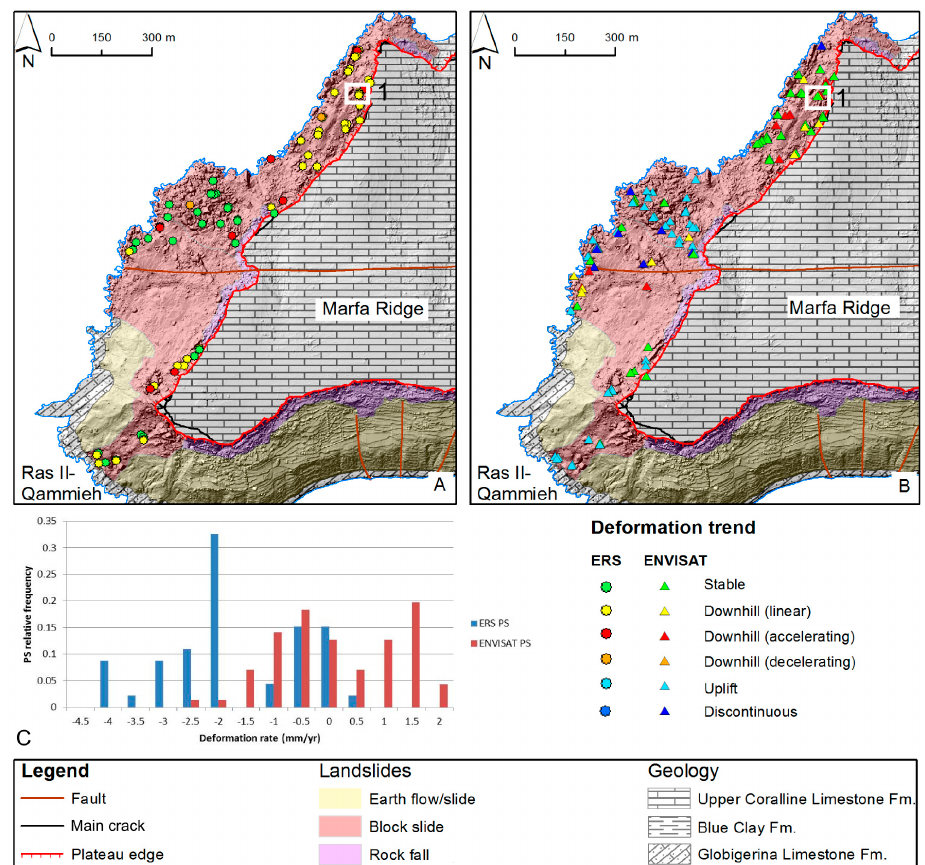
Figure 8. Marfa Ridge landslide map and distribution of the PS, color coded according to the trend classes defined in Figure 4: ( A ) ERS satellite PS deformation trend; ( B ) ENVISAT satellite PS deformation trend; ( C ) Histogram showing the relative frequency of occurrence in each class of movement rate. The white box on the map locates the PS whose time series are reported in Figure 6a.